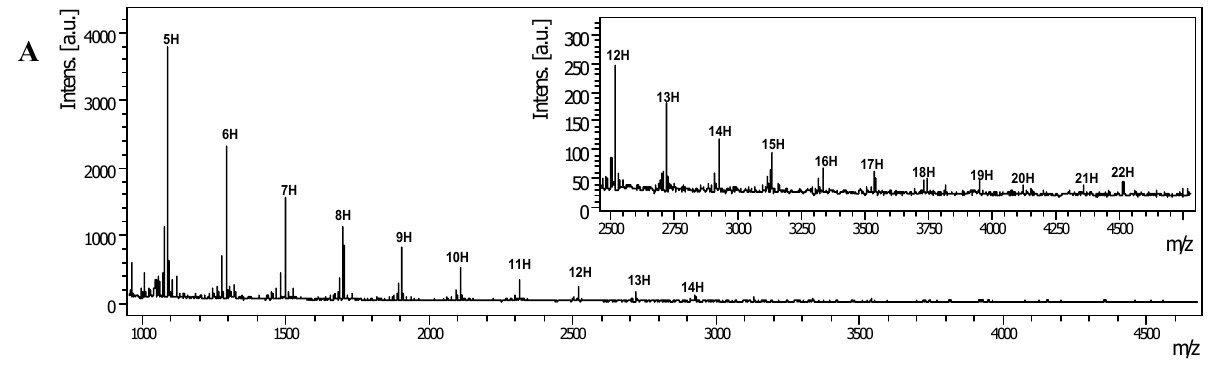
Figure 2. ( A ) MALDI-TOF MS spectrum of permethylated glucomannan. ( B ) MALDI-TOF MS spectrum of permethylated dextran (DP = 5 to 22). ( C ) MALDI-TOF MS spectrum of permethylated arabinogalactan. ( D ) MALDI-TOF MS of permethylated alginic acid. The conditions of MALDI-TOF MS are the same as that described in Figure